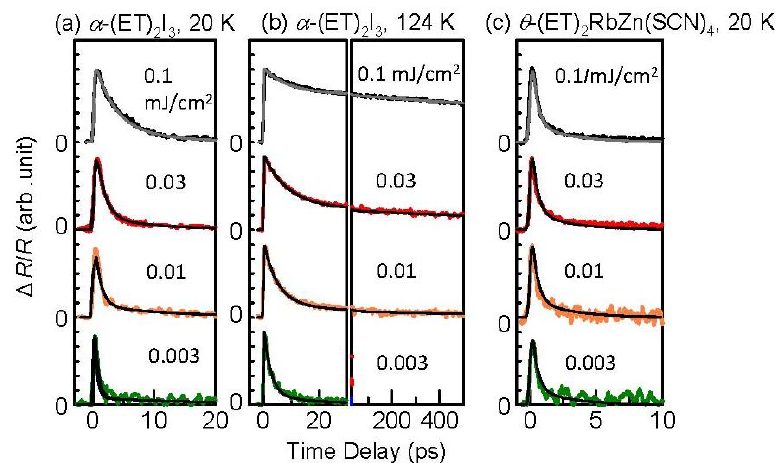
Figure 10. Schematic illustrations of ( a ) initially produced microscopic metallic domains; ( b ) fast recovery of the charge-ordered state in  -(ET) metallic domain in α-(ET)